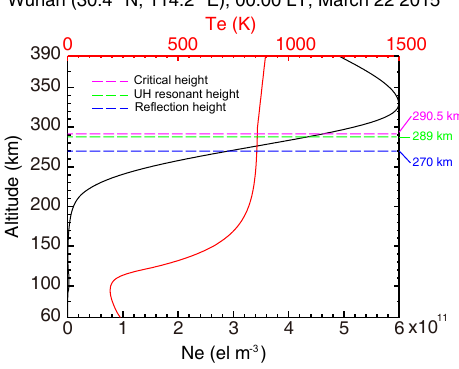
Figure 1. The ionospheric electron density (black line) and tem- perature profiles (red line) used for the ionospheric background ob- tained from the IRI-2012 model. The purple dotted line indicates the critical height of the heating frequency. The green line indicates the upper-hybrid resonant height. The blue line indicates the reflection height of the heating waves in the